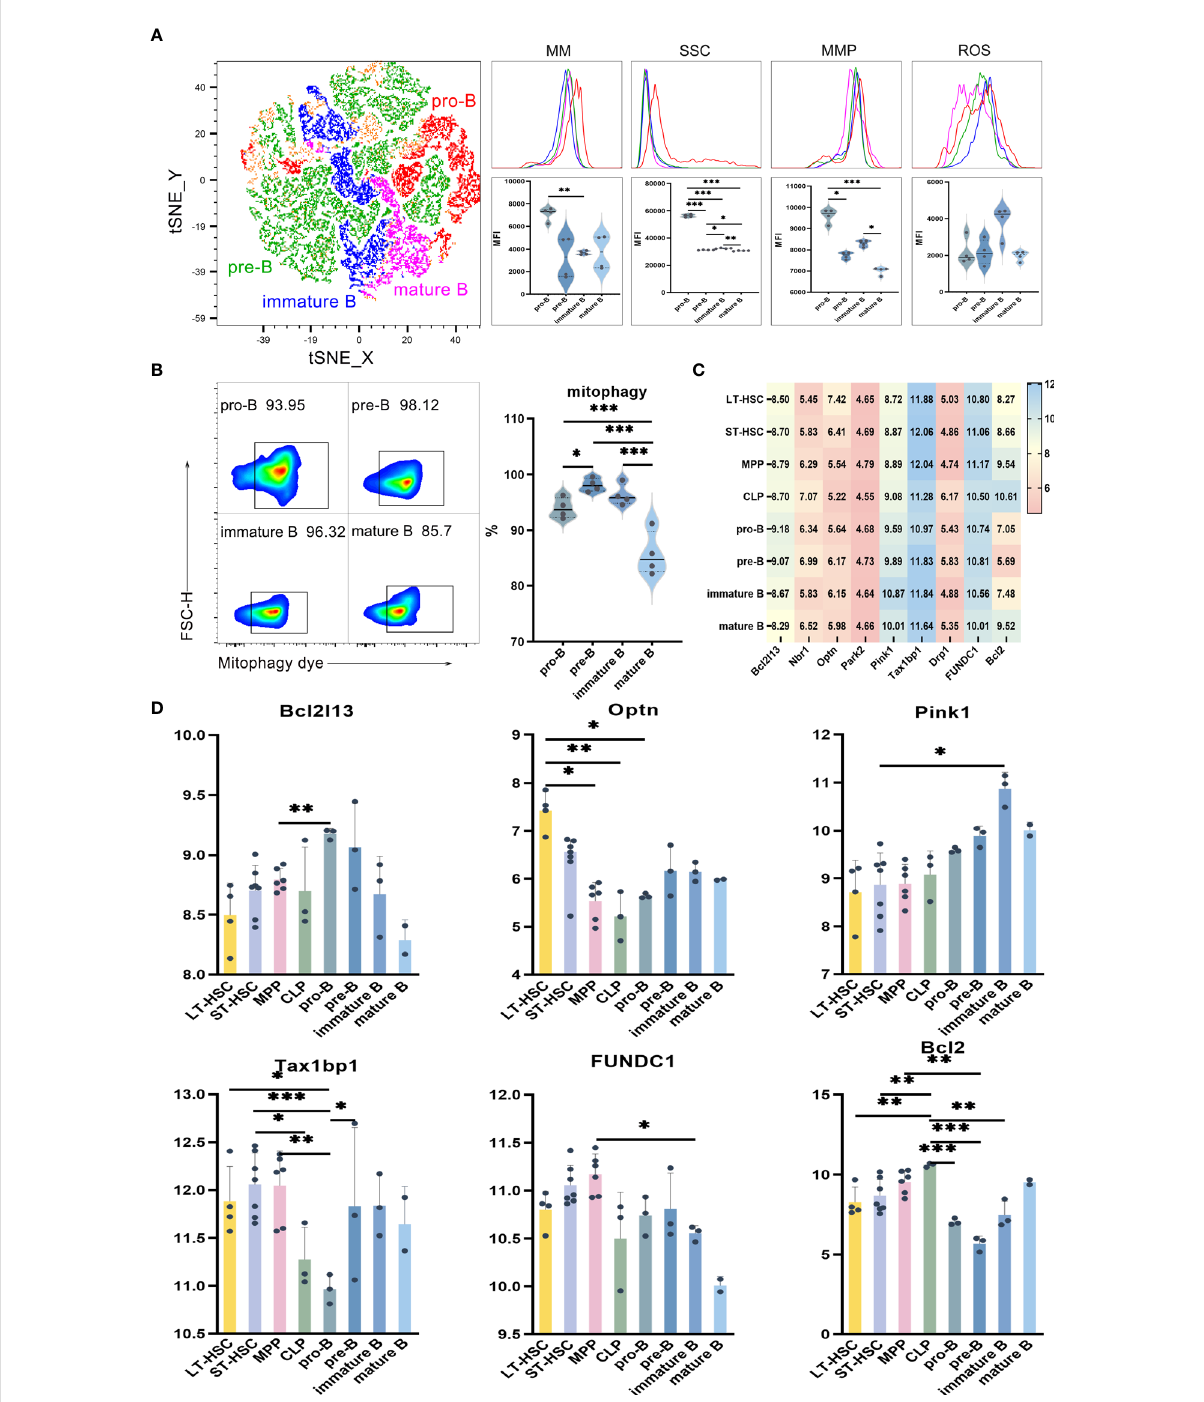
FIGURE 3 (A) t-SNE, MM, SSC, MMP and ROS levels in pro-B, pre-B, immature B and mature B cells (B) Mitophagy in pro-B, pre-B, immature B and mature B cells (C) Heat map for the expression level of autophagy-related genes in B cells at different differentiation stages (D) Statistics for the expression level of autophagy-related genes. Normally-distributed data are presented as the mean ± SD, while non-normally-distributed ones are presented as the median with the interquartile range. One-way ANOVA or the Kruskal – Wallis test was used for comparisons and determining the P values. * P <0.05, ** P <0.01, *** P